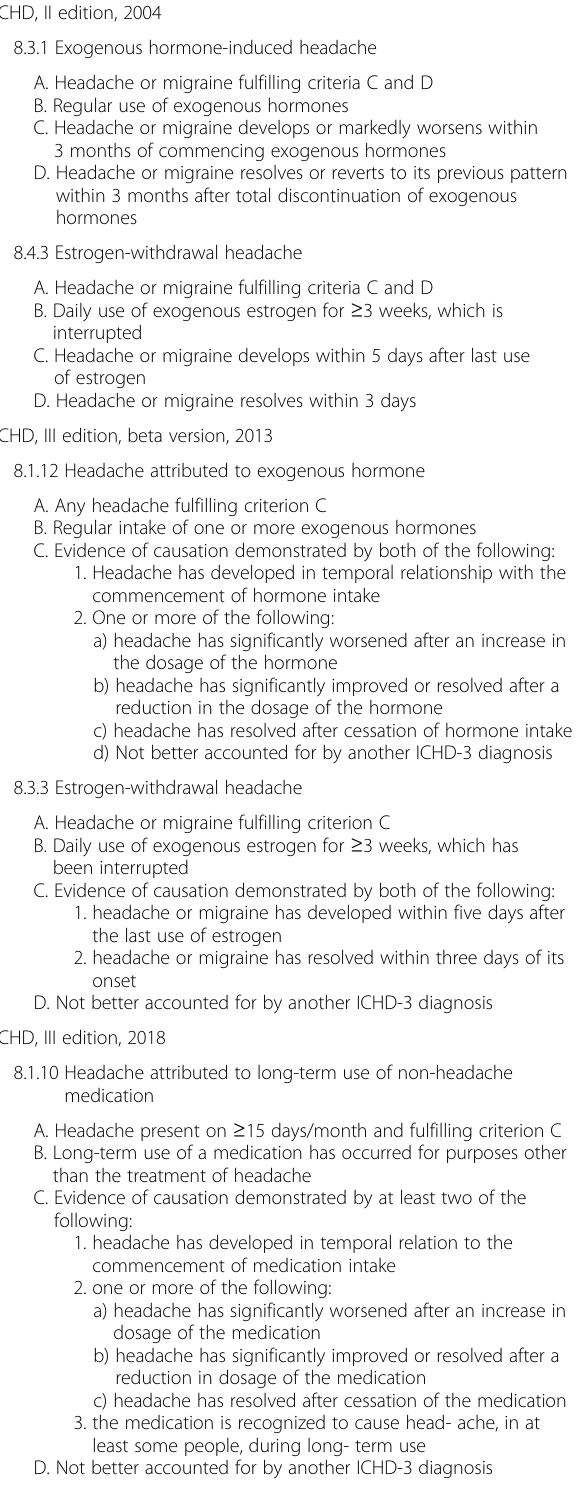
Table 2 Diagnostic criteria of headache related to the use and to the withdrawal of hormones according to the different editions of